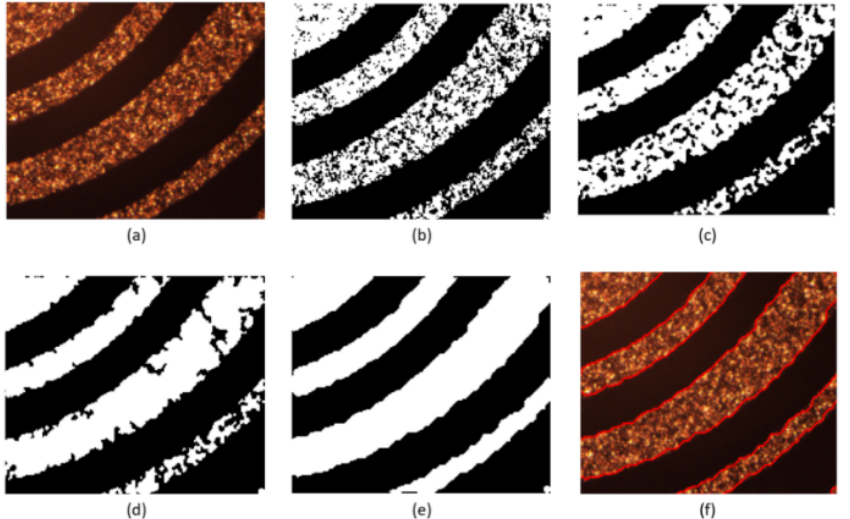
Figure 10. Display diagram of the algorithm for feature extraction of normal lines. ( a ) is the original image; ( b ) is the image classified by the K-means algorithm; ( c ) is the image after median filtering; ( d ) is the image after the morphological filling hole algorithm; ( e ) is the image after the closing operation and ( f ) is the image obtained after the feature extraction of the model in this paper.